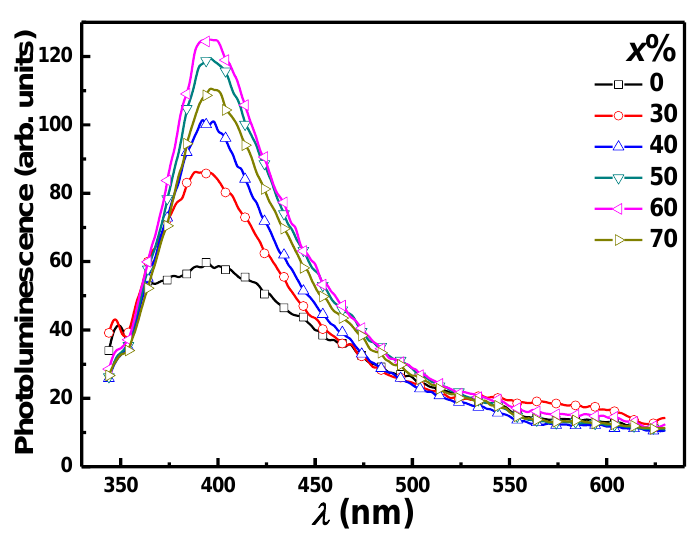
Figure 5. PL emission spectra as a function of λ for PbO- x % Al 2 O 3 composites. Apart from investigating and determining the structural and optical bandgaps of PbO- x % Al 2 O 3 composites, these composites were also used as a catalyst for water purification or water decolorizations from waste dyes such as MB, with the use of ultraviolet irradiation. Figure 6a,b show the representative absorbance spectra as a function of incident radiation wavelength ( λ ) during the removal of MB utilizing pure PbO and Al 2 O 3 nanoparticles as catalysts for different irradiation periods (up to 105 min). The occurrence of one unique maximum situated at λ = 665 nm is what characterizes the absorbance of MB solutions, according to the relationship between absorbance and λ . Furthermore, increasing the irradiation time reduces the amount of radiation absorbed by the MB solution. This decrease demonstrates the efficacy of PbO or Al 2 O 3 nanoparticles as a catalyst for removing the MB dye, and hence the possibility of wastewater treatment via photocatalytic degradation processes. The absorbance was decreased from 0.90 to 0.68 for the PbO catalyst, while for the Al 2 O 3 catalyst was reduced from 0.78 to 0.62 as the irradiation time reached 105 min. Similar experiments (not shown here) were carried out for the other samples that contained both PbO, and Al 2 O 3 to form PbO- x %Al 2 O 3 composites. Figure 7a illustrates the MB dye photodegradation rate ( C t ) versus the irradiation C o time ( t ) for PbO- x %Al 2 O 3 composites. It is obvious from the figure that the PbO-40%Al 2 O 3 composites showed a faster degradation rate of the MB and was reached a constant value after 20 min of the UV-visible irradiation. On another side, the PbO-10%Al 2 O 3 composites revealed the highest value of photocatalytic activity compared to other composites. On the other hand, pure Al 2 O 3 (100% Al 2 O 3 ) nanoparticles had a lower photocatalytic activity value, which could be related to the greater bandgap limiting the visible absorption region.